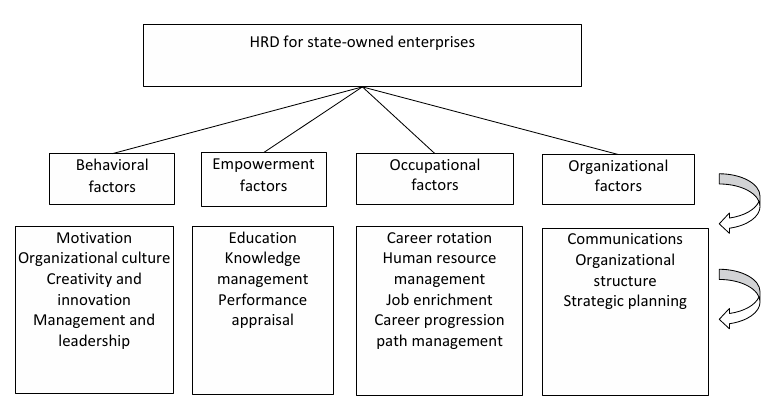
Fig. 5. A model with the research network structure for HRD for SOE Table 8. The weight and importance of the dimensions and criteria of HRD for SOE Weight and rank of Criteria Code Weight and relative rank Weight and final rank of dimensions of criteria criteria